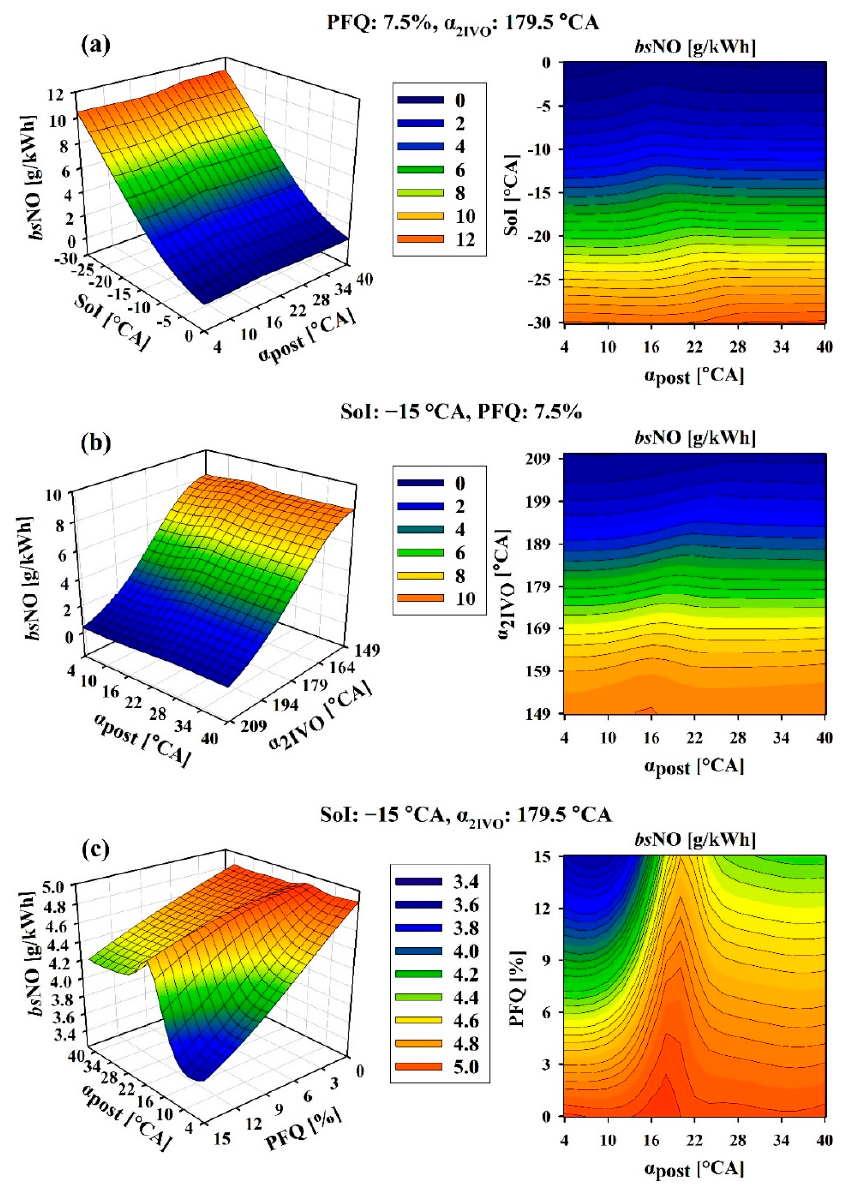
Figure 14. bsNO response surfaces for ( a ) α post —SoI, ( b ) α post — α 2IVO and ( c ) PFQ— α post .